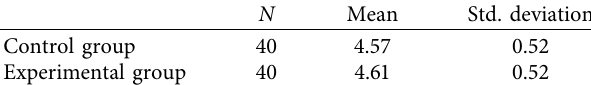
Table 1: Descriptive statistics for the